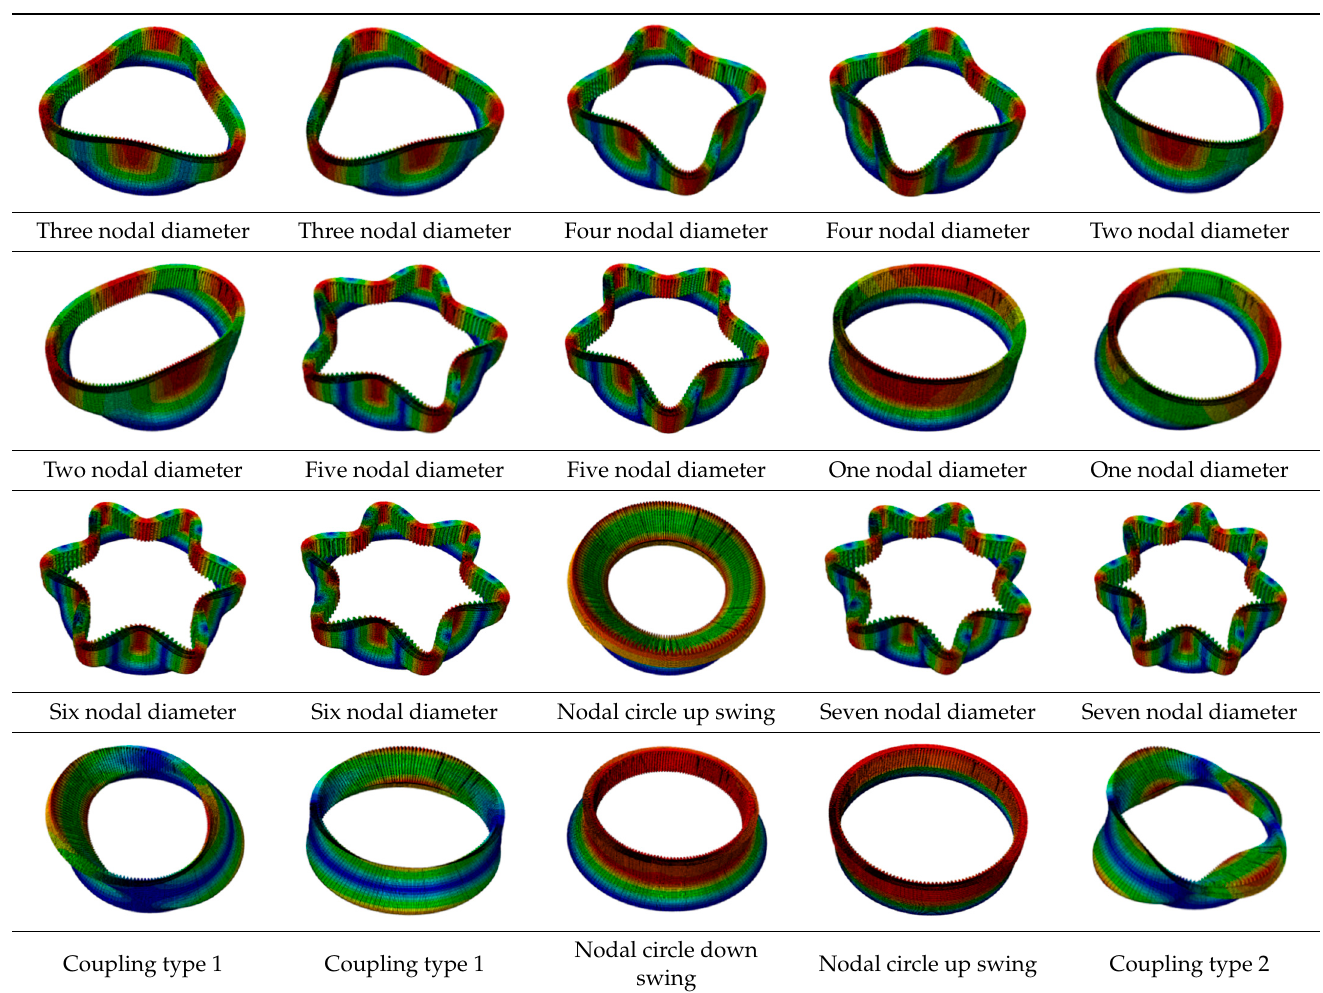
Table 3. The first 20 vibration modes of L-shaped flexible ring gear.